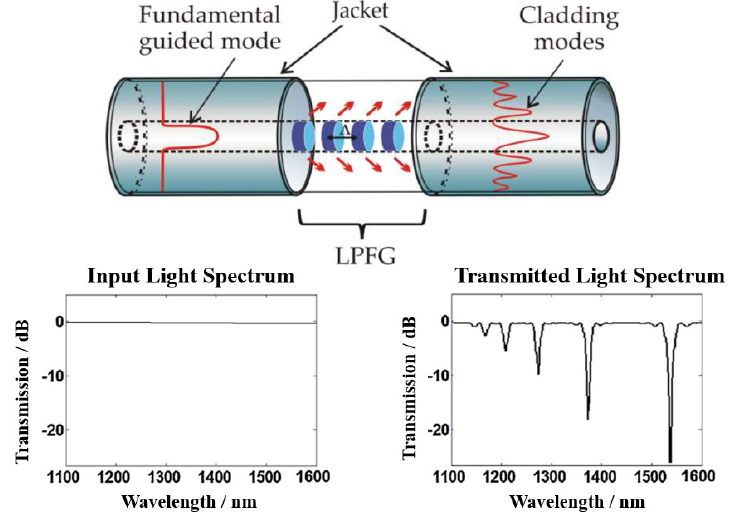
Figure 10. Schematic of long-period grating (LPG) structure [79] and an example of transmitted light spectrum after passing through LPG (Reprinted from Reference [80] with permission from Elsevier).